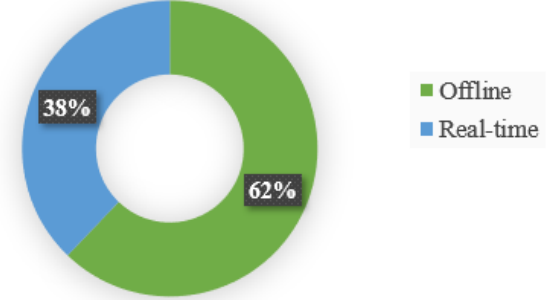
Figure 12. Offline/real-time implementation.